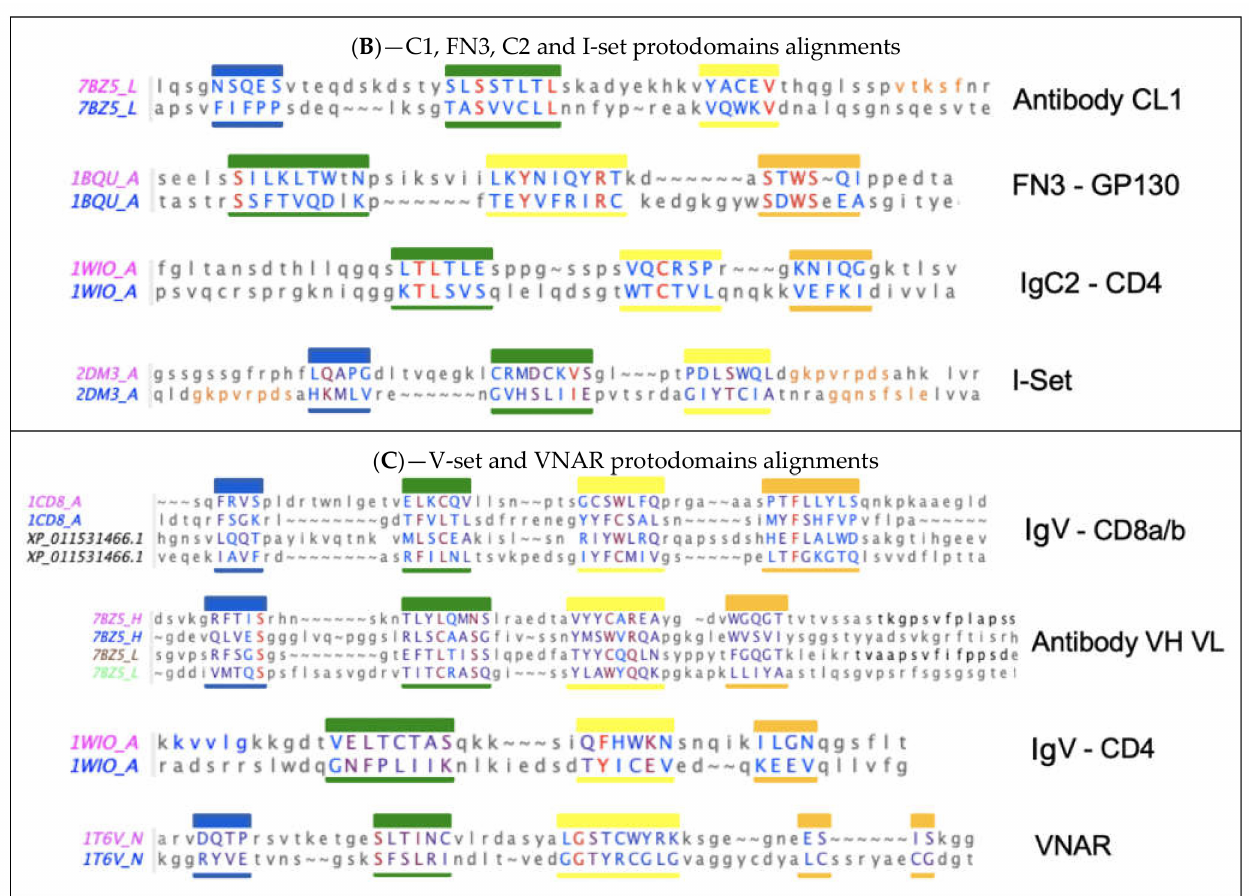
Figure 2. Sequence/topology maps comparison of topological variants of single Ig domains. ( A ) Sequence/topology maps: C1-set, C2-set, FN3, I-set, VNAR, and V-set for CD8a/CD8b and for CD4. See text for details on differences. Capital letters are used for structurally aligned residues. Colors are the same for matching strands in protodomains: blue for strands A and D, green for B and E (a full sheet ABED will read blue–green–green–blue), yellow for strands C and F, orange for strand C’ and G, and red for C” “IgV “linkers”. Colors green and yellow of central strands highlight the self-assembly of strand B-E and C-F of protodomains. FN3 and IgC2 have a similar topology, but FN3 does not share the CCW(L) present in all the selected Ig domains highlighted in central strands. Some IgV domains, such as CD2, however, can also miss that pattern (not shown). IgVs have a C” strand highlighted in red. We have highlighted CD8a and CD8b that form either homo- or heterodimers, with a split A/A’ strand where A’ swaps from one sheet, i.e., antiparallel to strand B and parallel to strand G, while CD4 IgV represents another type where the strand A is only on one sheet in parallel to strand G. VNAR shares the split strand A/A’ of IgVs, which is also present in the Ig-I set. The I-set is very similar to VNARs that have only a few more residues in their HV2 region that encompass a short C’ strand antiparallel to C, and a C’-D linker that is structurally superimposable in VNAR and I-set. In fact, the overall structural alignment is very good with an RMSD of 1.83A and a surprisingly good sequence match (https://structure.ncbi.nlm.nih.gov/icn3d/share.html?c8F4iowua2TAD6ej8, accessed on 27 August 2021) ( B ) Alignment of protodomains in C1-, C2- and I-set domains. Colors, as in A, show the corresponding strands aligning 3 out of 4 strands due to symmetry breaking (see text). In the I-set, the G strand is shown in orange, as well as that which would be C’ when comparing with IgVs, if it were not a protodomain “linker” in the I-set context. RMSD for protodomain alignments are for C1: 1.19 A, FN3: 1.8 A, C2: 1.98 A, I: 2.46 A (iCn3d self-alignment of 2DM3: https://structure.ncbi.nlm.nih.gov/icn3d/share.html?tBzknU8spazpwCup7, accessed on 27 August 2021) ( C ) Alignment of protodomains in IgVs and VNAR domains. The symmetry breaking (see text) also extends to CD4-like IgVs, where strand A is swapped in protodomain 1 vs. strand D in protodomain 2. In other IgVs, such as CD8 or antibody VH-VL domains that we added for completeness, or in VNAR, the strand A is split A/A’, as in the I-set, and keeps a symmetric correspondence with strand D, overall, in all 4 strands AB-CC’ vs. DE-FG, with only a partial symmetry breaking through strand A’. Protodomain alignments consistently show a structural match for conserved and co-evolved residues C in strand B and strand F vs. residues W and (most often) L in strand C and strand E, respectively. RMSD